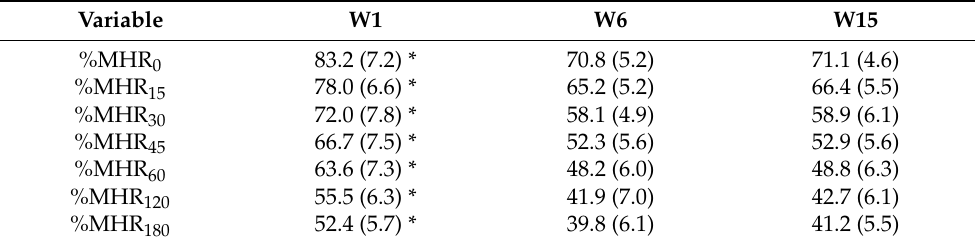
Table 2. Changes in HRR responses during the firefighter recruit training academy, n = 25. Variable